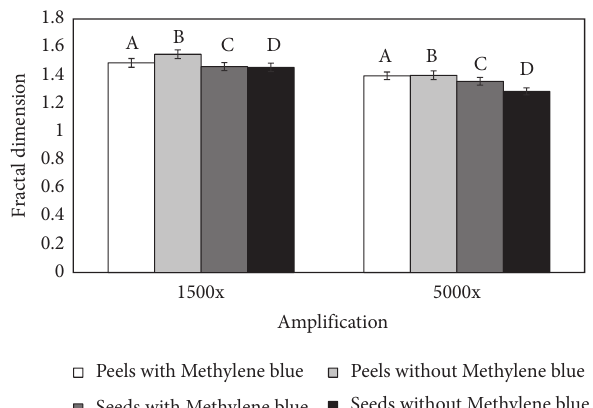
Figure 13: Fractal dimension of the SEM microstructure of adsorbents: peels and seeds before (B and D) and after (A and C) MB adsorption at 1500x and